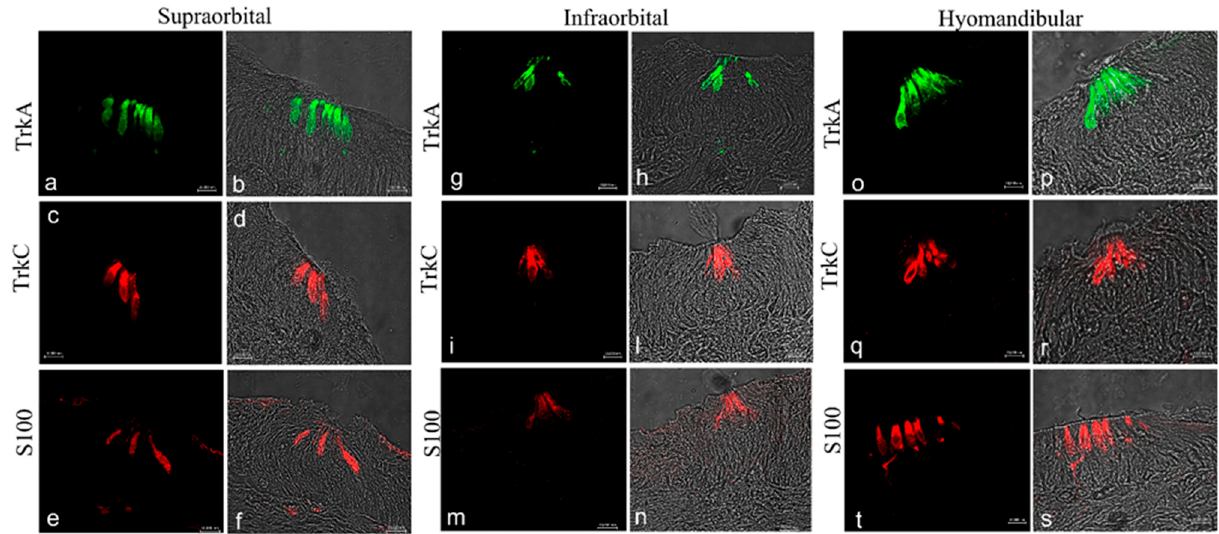
Figure 7. Lateral line system of N. guentheri head; transversal view. Immunohistochemical detection (immunofluorescence method) of TrkA, TrkC, and S100 protein. Supraorbital ( a – f ), infraorbital ( g – i , l – n ), and iomandibular free neuromast ( o – t ) in N. guentheri head show a group of sensory hair cells supported by supporting cells and laterally surrounded by long mantle cells. The hair cells in supraorbital, infraorbital, and hyomandibular free neuromast displayed cytoplasmatic immunoreactivity for TrkA, TrkC, and S100 protein. Magnification 40 ×